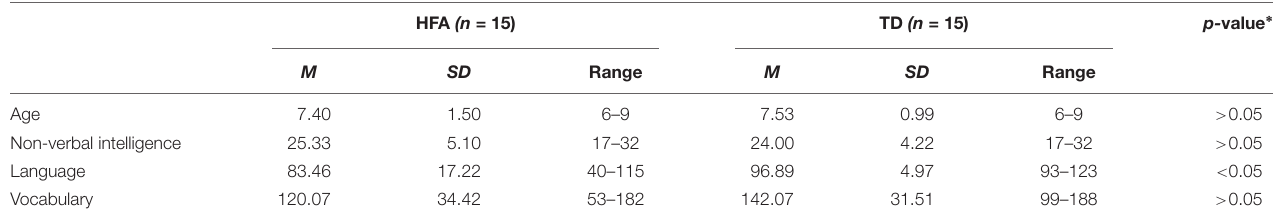
TABLE 1 | Mean (M), standard deviation (SD) and range for age, non-verbal intelligence, language, and vocabulary of the participants in the high-functioning autism (HFA) and typically developing (TD) groups. HFA (n = 15) TD (n = 15) p- value ∗ M SD Range M